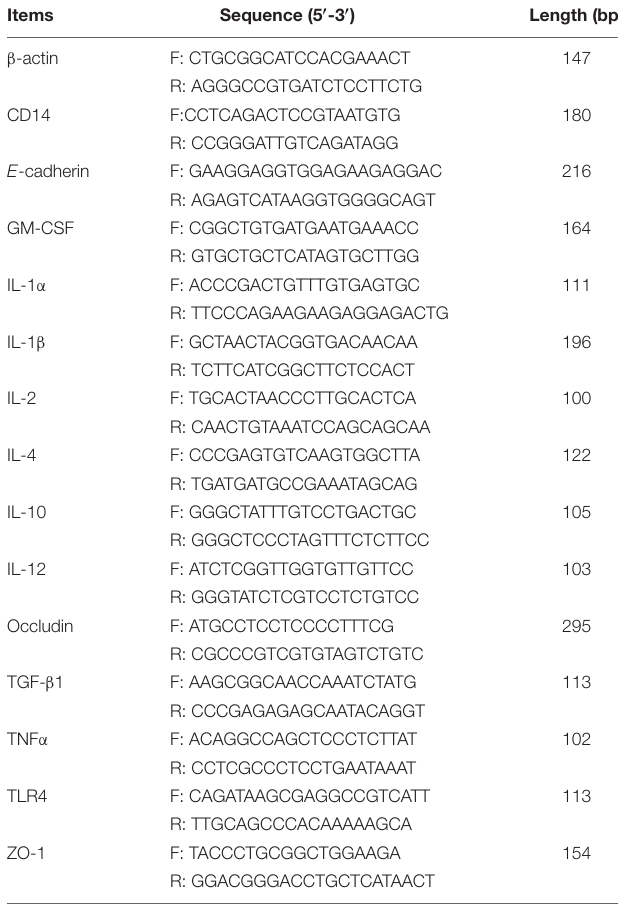
TABLE 4 | Primers used for quantitative reverse transcription